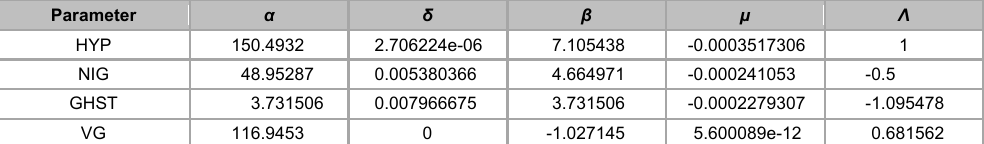
Parameter estimates of the GHDs for the daily USD/ZAR exchange